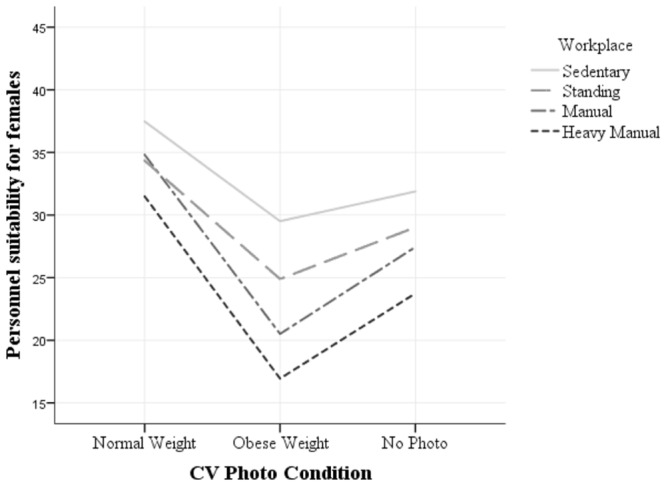
Three Way Interaction of Gender × Photo × Workplace (female).